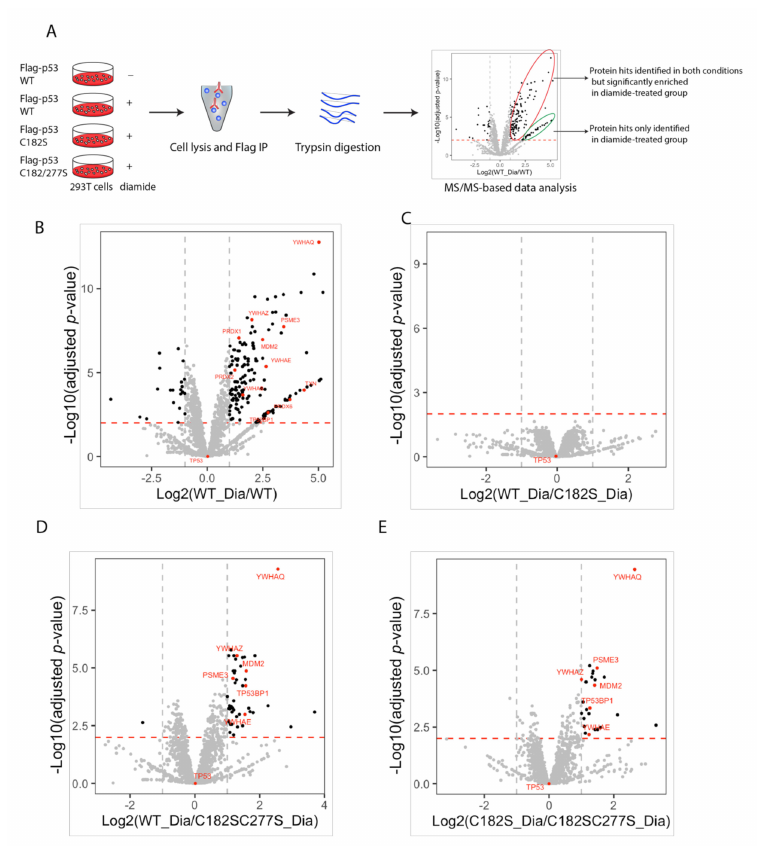
Figure 3. Identification of disulfide-dependent p53 interactors by MS/MS analysis. ( A ) Scheme for the identification of p53 disulfide-dependent interactors by MS/MS. HEK293T cells were transfected with Flag-p53 WT, C182S, and C182S,C277S. 48h after transfection, cells were treated with diamide, followed by immunoprecipitation and processing for MS/MS. MS data were further analyzed in R and plotted in a volcano plot. Protein hits with >2-fold enrichment and an adjusted p -value < 0.01, are considered significant interactors (black dots). Hits circled in red are identified in both conditions, whereas the green circle indicates proteins identified in only one of the samples. Data analysis was based on 4 biological replicates for each condition. ( B ) Volcano plot showing interactors of Flag-p53 WT with and without diamide treatment. ( C ) Volcano plot showing interactors of Flag-p53 WT vs. C182S, both with diamide treatment. ( D ) Volcano plot showing interactors of Flag-p53 WT vs. C182S,C277S, both with diamide treatment. ( E ) Volcano plot showing interactors of Flag-p53 C182S vs. C182S,C277S, both with diamide